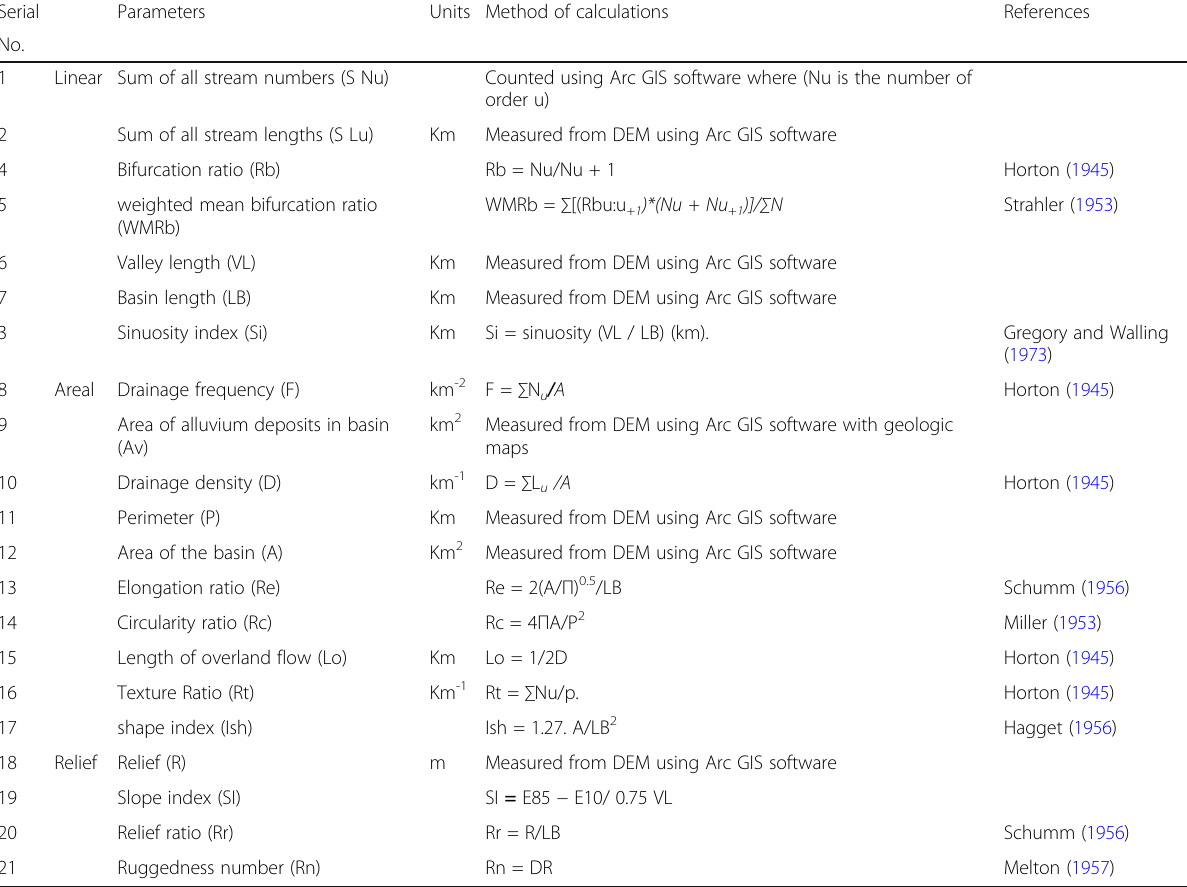
Table 1 Methodology used for calculation of the morphometric